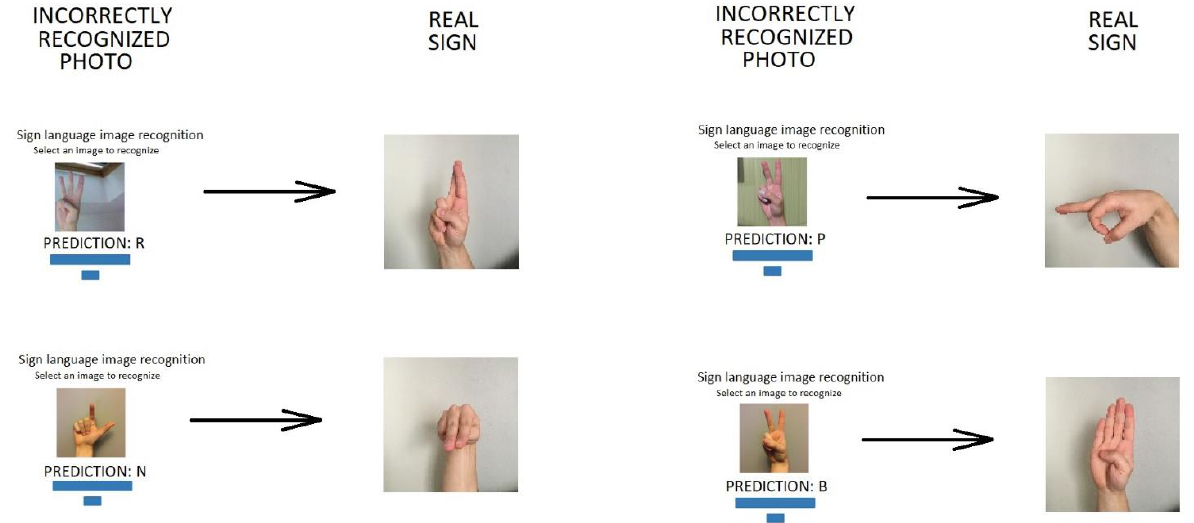
Figure 7. Examples of incorrectly recognized sign language